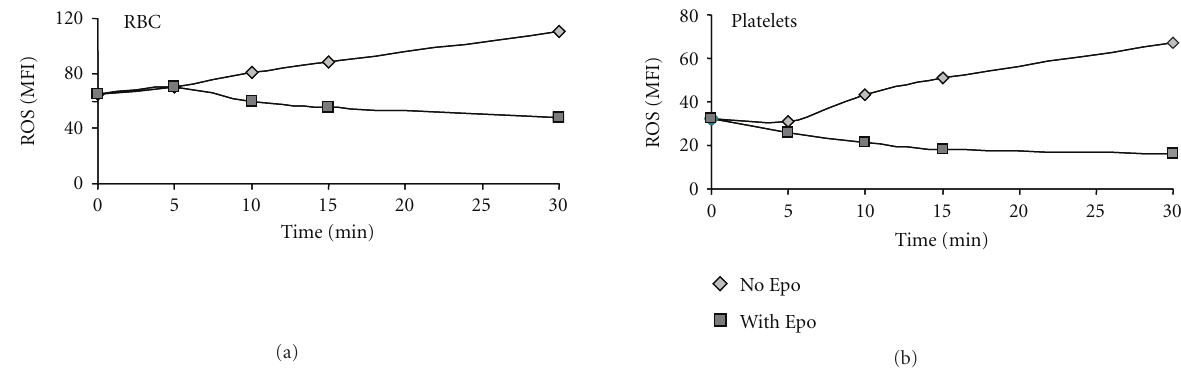
Figure 2: The kinetics of EPO e ff ect on ROS generation by RBC and platelets. A diluted blood sample obtained from a thalassemia patient was stained with DCF, washed, and then incubated at room temperature with Epo (1U/ml). Fluorescence was measured by flow cytometry at the indicated time points. The time-related changes in the mean fluorescent intensity (MFI) of each population are indicated.